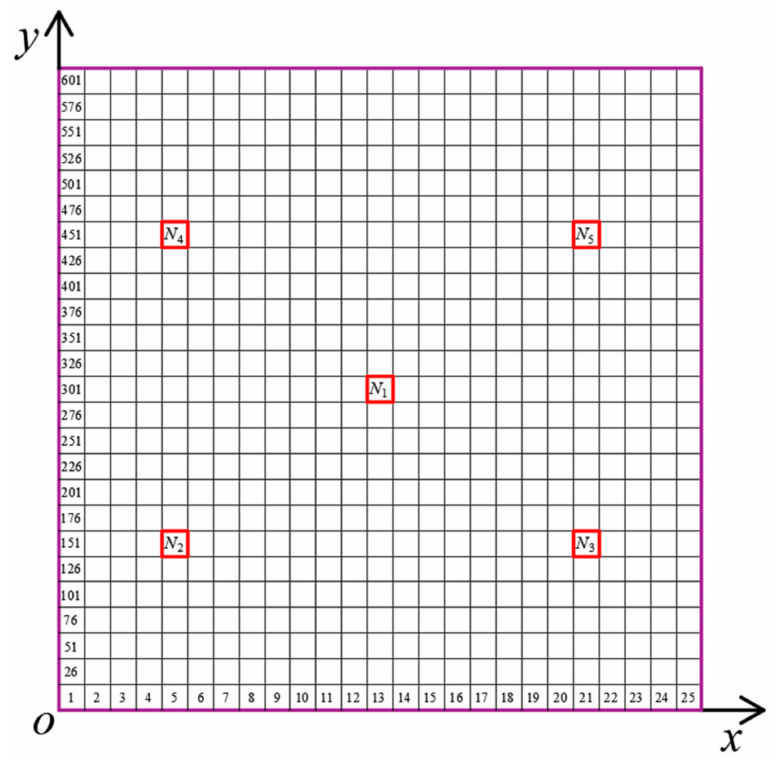
Figure 2. Units in two-dimensional coordinate